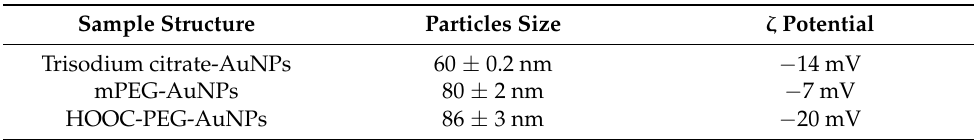
Table 1. Comparation of ζ potential values and particles size between the non-PEGylated and PEGylated gold nanoparticles.